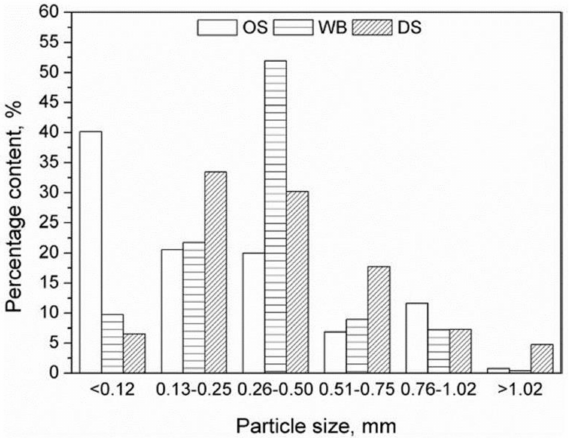
Figure 6. Particle size distribution of analyzed lignocellulosic fillers